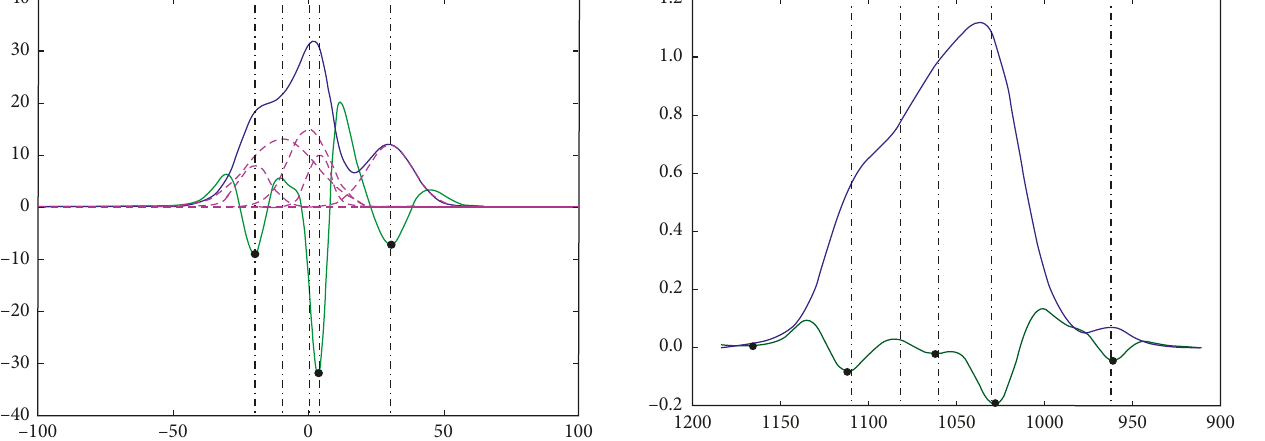
Figure 14: Second derivative method applied to a 5-peak spectrum (in dashed-black line, the true position of peaks. The found peaks are highlighted with a black